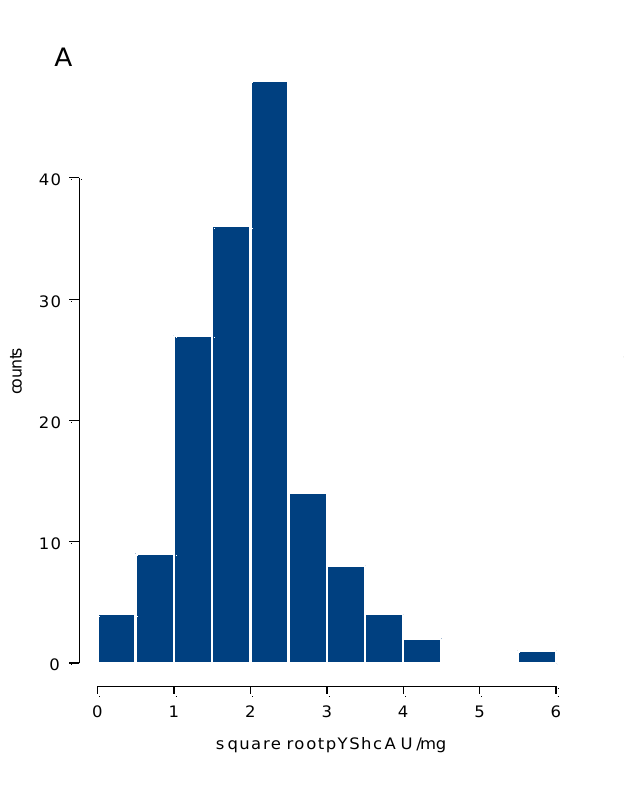
Figure 1. Histograms showing distribution of square root values of ( A ). pYShcA and ( B ). pSShcA expression levels in 153 primary breast cancer samples by